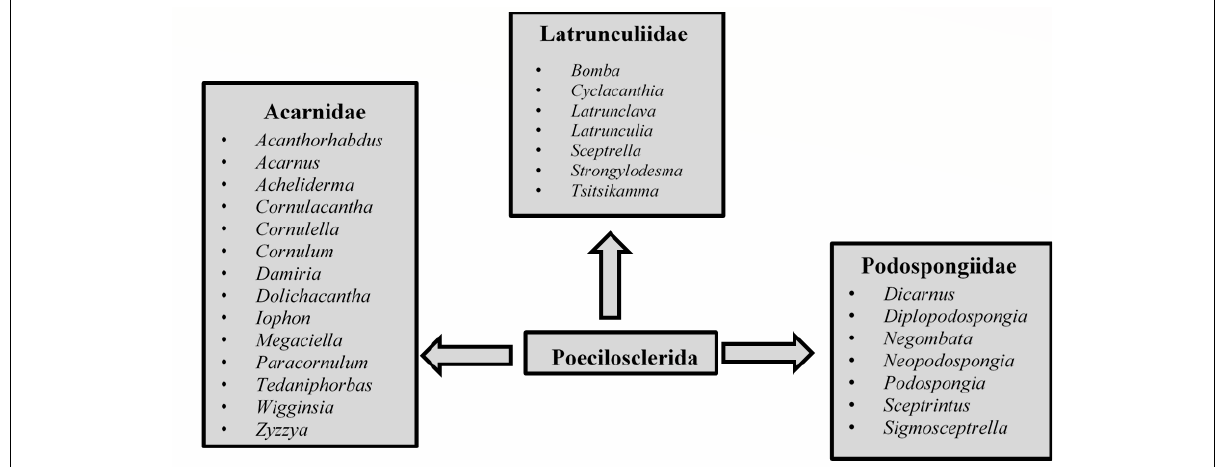
Figure 2: Three taxonomic families ascribed to the sponge order Poecilosclerida.